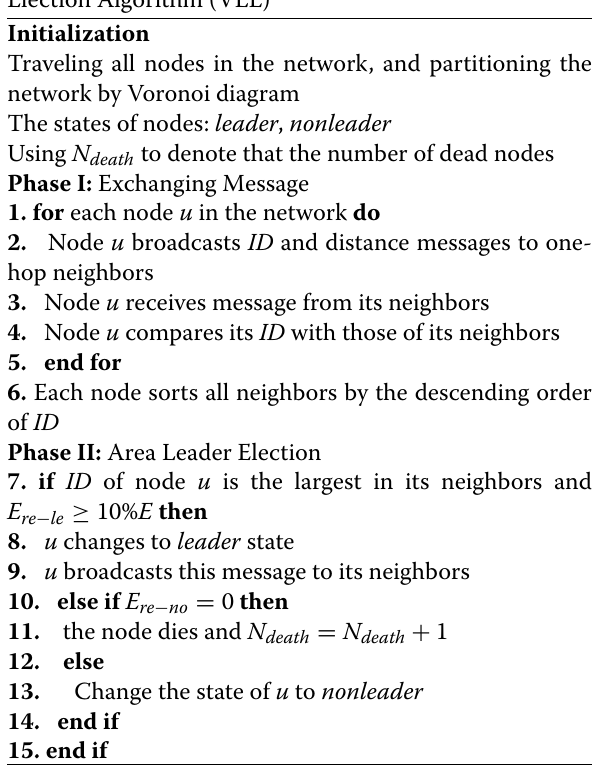
Algorithm 1 Algorithm 1: Voronoi based Multi-leader Election Algorithm (VLE)